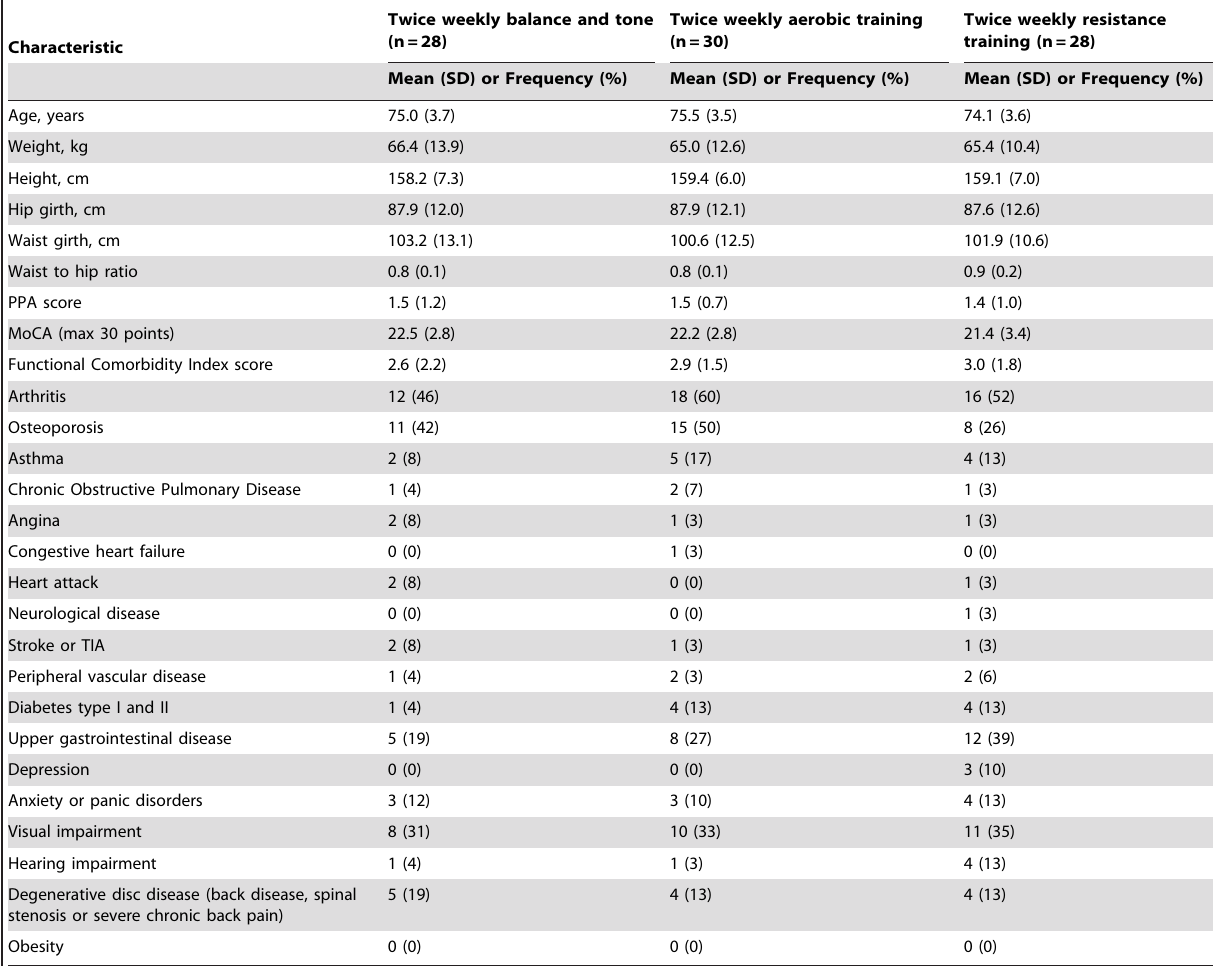
Table 1. Characteristics of participants at entry to trial.